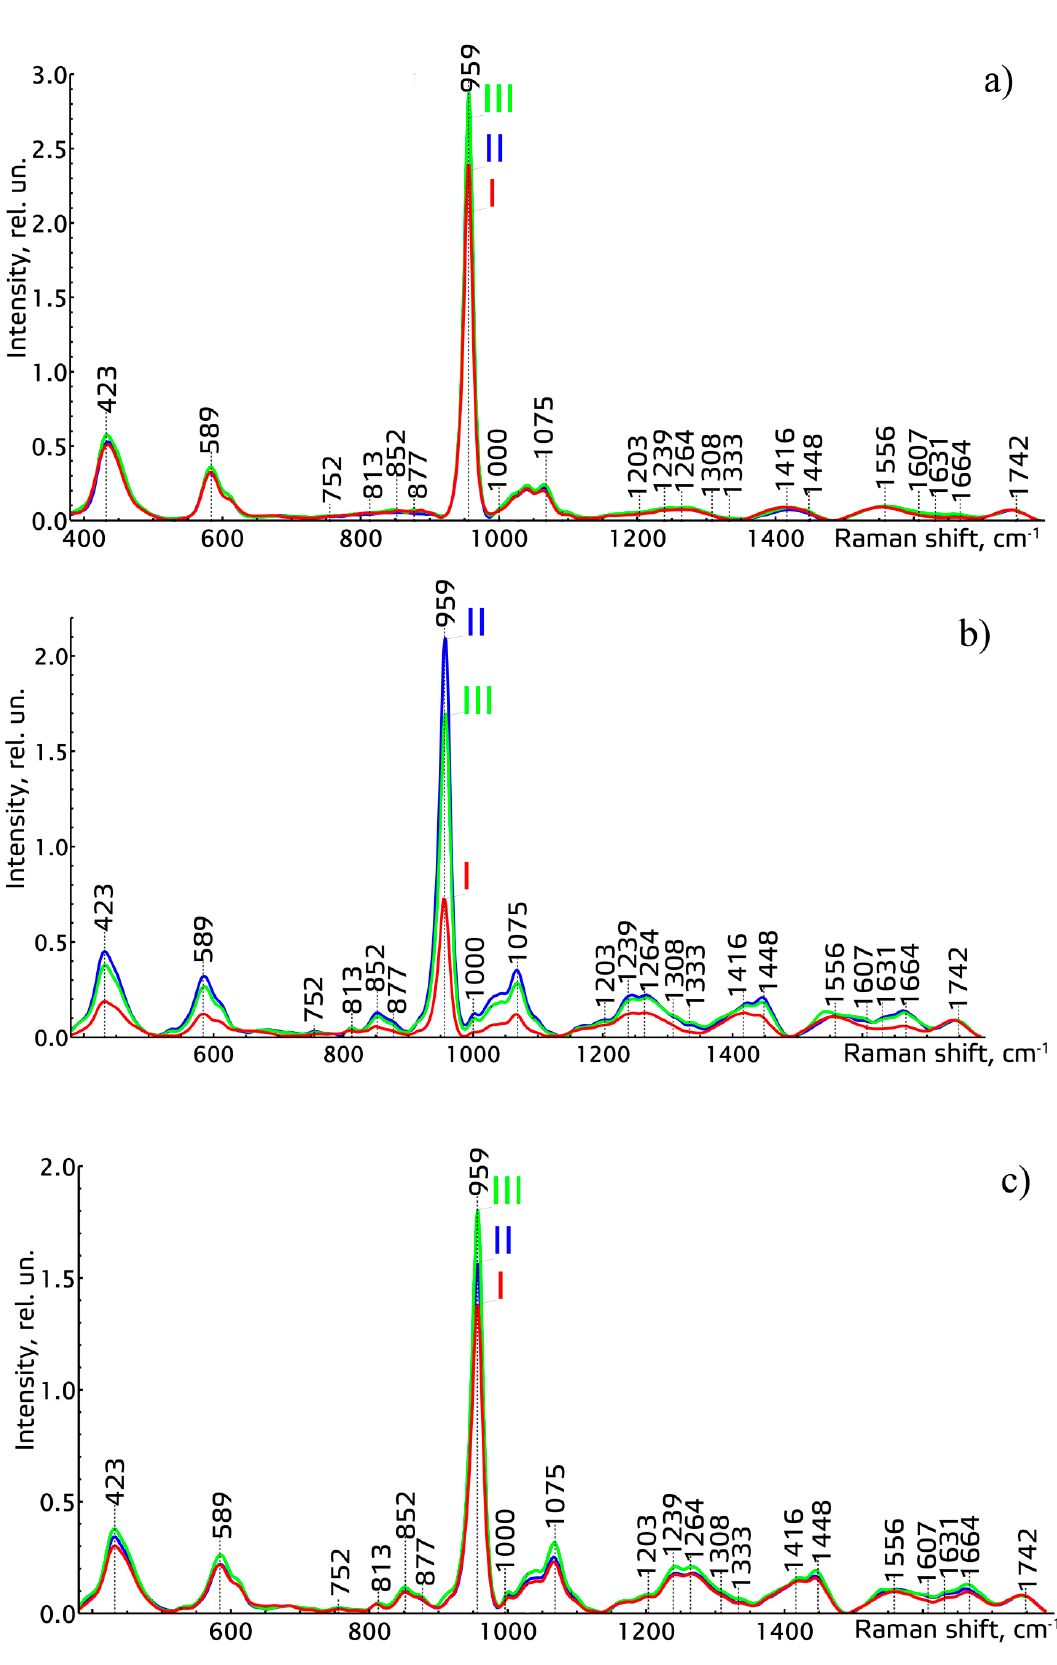
Figure 1. The normalized Raman spectra of enamel ( a ), dentin ( b ), and cementum ( c ) of teeth of the studied groups I–III. The analysis of the Raman spectra of different tissues of teeth of all the studied groups showed that similar spectral changes (intensity increase of the lines of ~589 cm − 1 , ~423 cm − 1 , ~959 cm − 1 , corresponding to hydroxyapatite, and ~1075 cm − 1 , corresponding to С - О planar valence fluctuation of hydroxyapatite carbonate ion С O 32 − ( ν 1)), take place af- ter the procedures of professional oral hygiene and closed curettage, in comparison to the group before the procedures. These spectral changes mainly occurred in the dentin and cementum of teeth. The spectral changes in dentin, after the procedures of scaling and root planning, were caused by penetrating the active mineral components into deeper tis- sues (dentin) of teeth through special dental tubules [18]. The spectral changes in cemen- tum after the procedures were caused by recovery of mineral components in the tissues and by forming new cementum, due to removing dental calculus and remineralization. To make the received Raman spectra more informative, a nonlinear regressive anal- ysis of the Raman spectra was conducted, including an investigation of their spectral line decomposition. The whole spectral range of 380–1780 cm − 1 was divided into four spectral contours: 1–380–508 ( adj R 2 = 0.9999), 2–508–1136 ( adj R 2 = 0.9978), 3–1136–1491 ( adj R 2 = 0.9998), 4–1491–1781 cm − 1 ( adj R 2 = 0.9998). Figure 2 shows the results of decomposition of the spectral contours on the sum of distribution of the Gaussian lines.